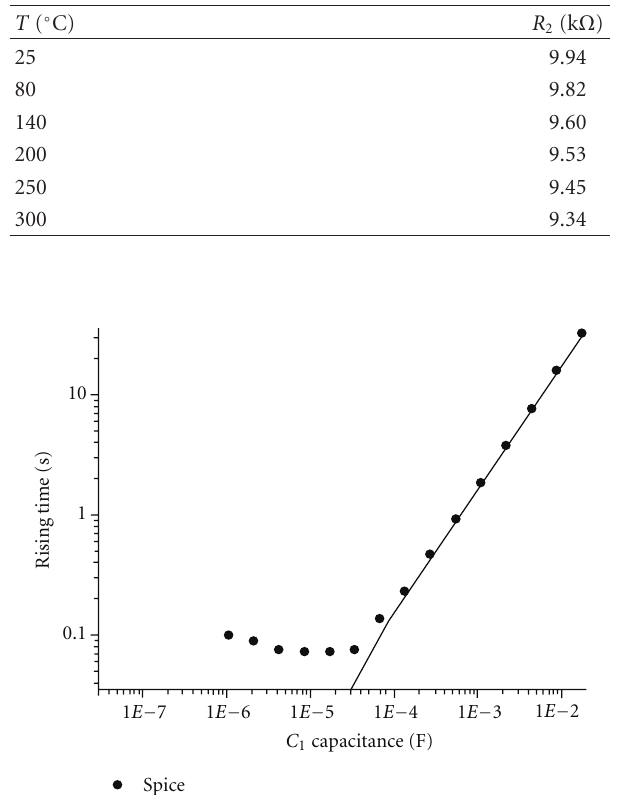
Table 1: R 2 Resistance changing range according to the temperature changing range in a real test.